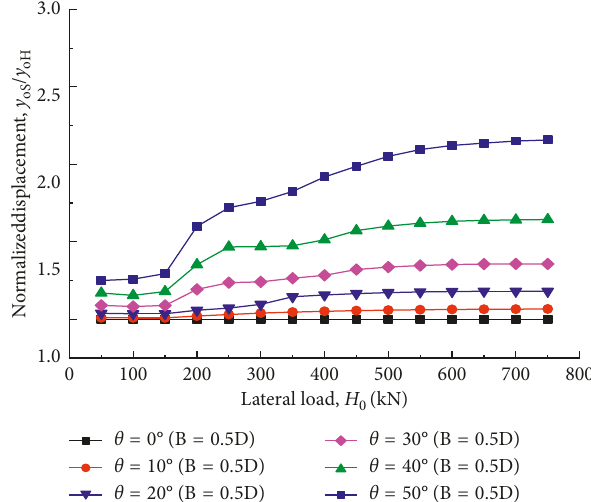
Figure 10: Normalized deflection ( y different slope angle.